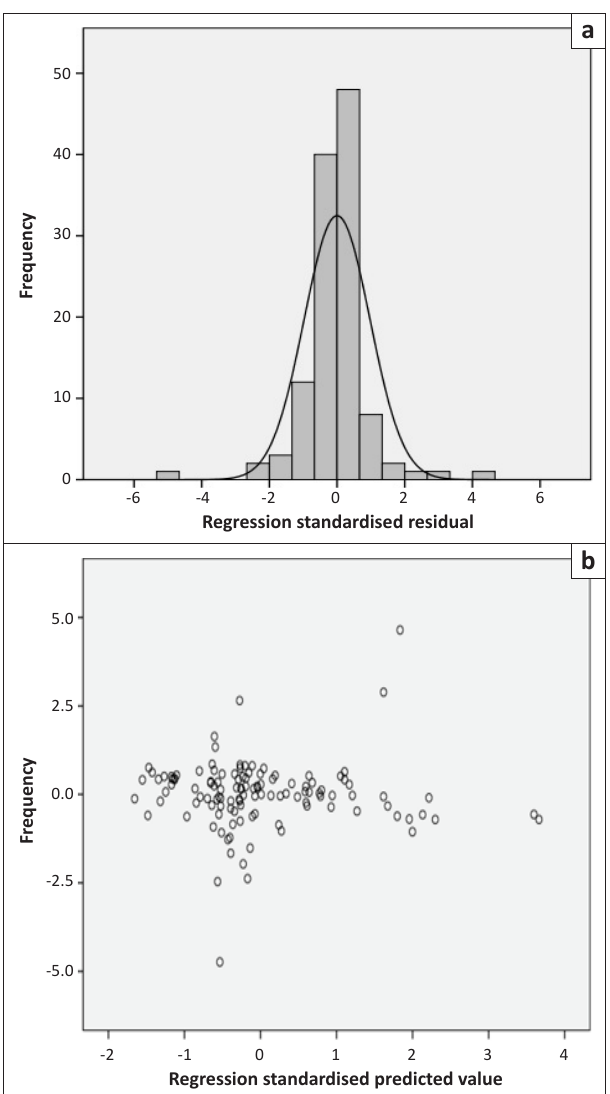
FIGURE 1: Normality, homogeneity and linearity: (a) Histogram and (b) scatterplot.